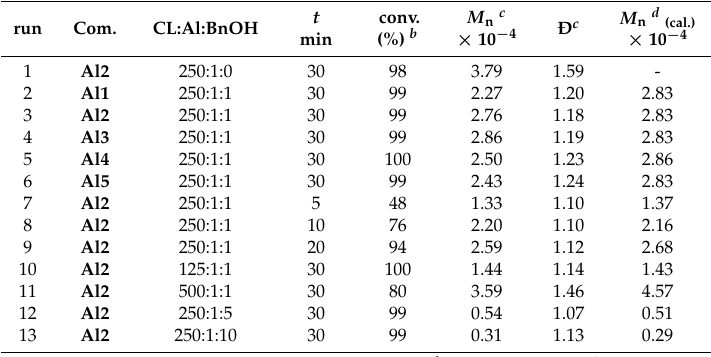
Table 1. Homopolymerization ROP of ε -CL by Al1 – Al5 /BnOH a .